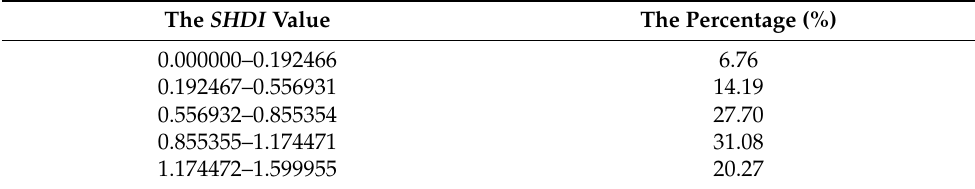
Table 3. The statistics of SHDI value within the